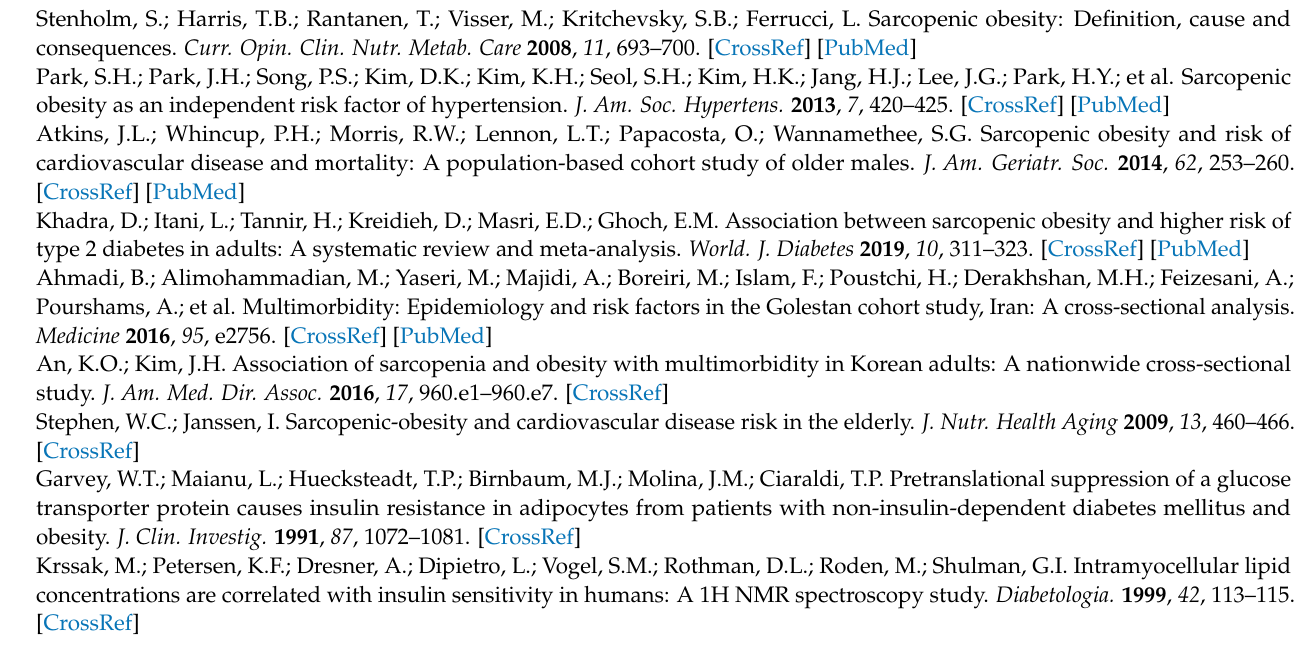
reference group, Table S2: Characteristics and comparisons of study participants, Table S3: The sex-specific differences in and trends of participants by TyG index